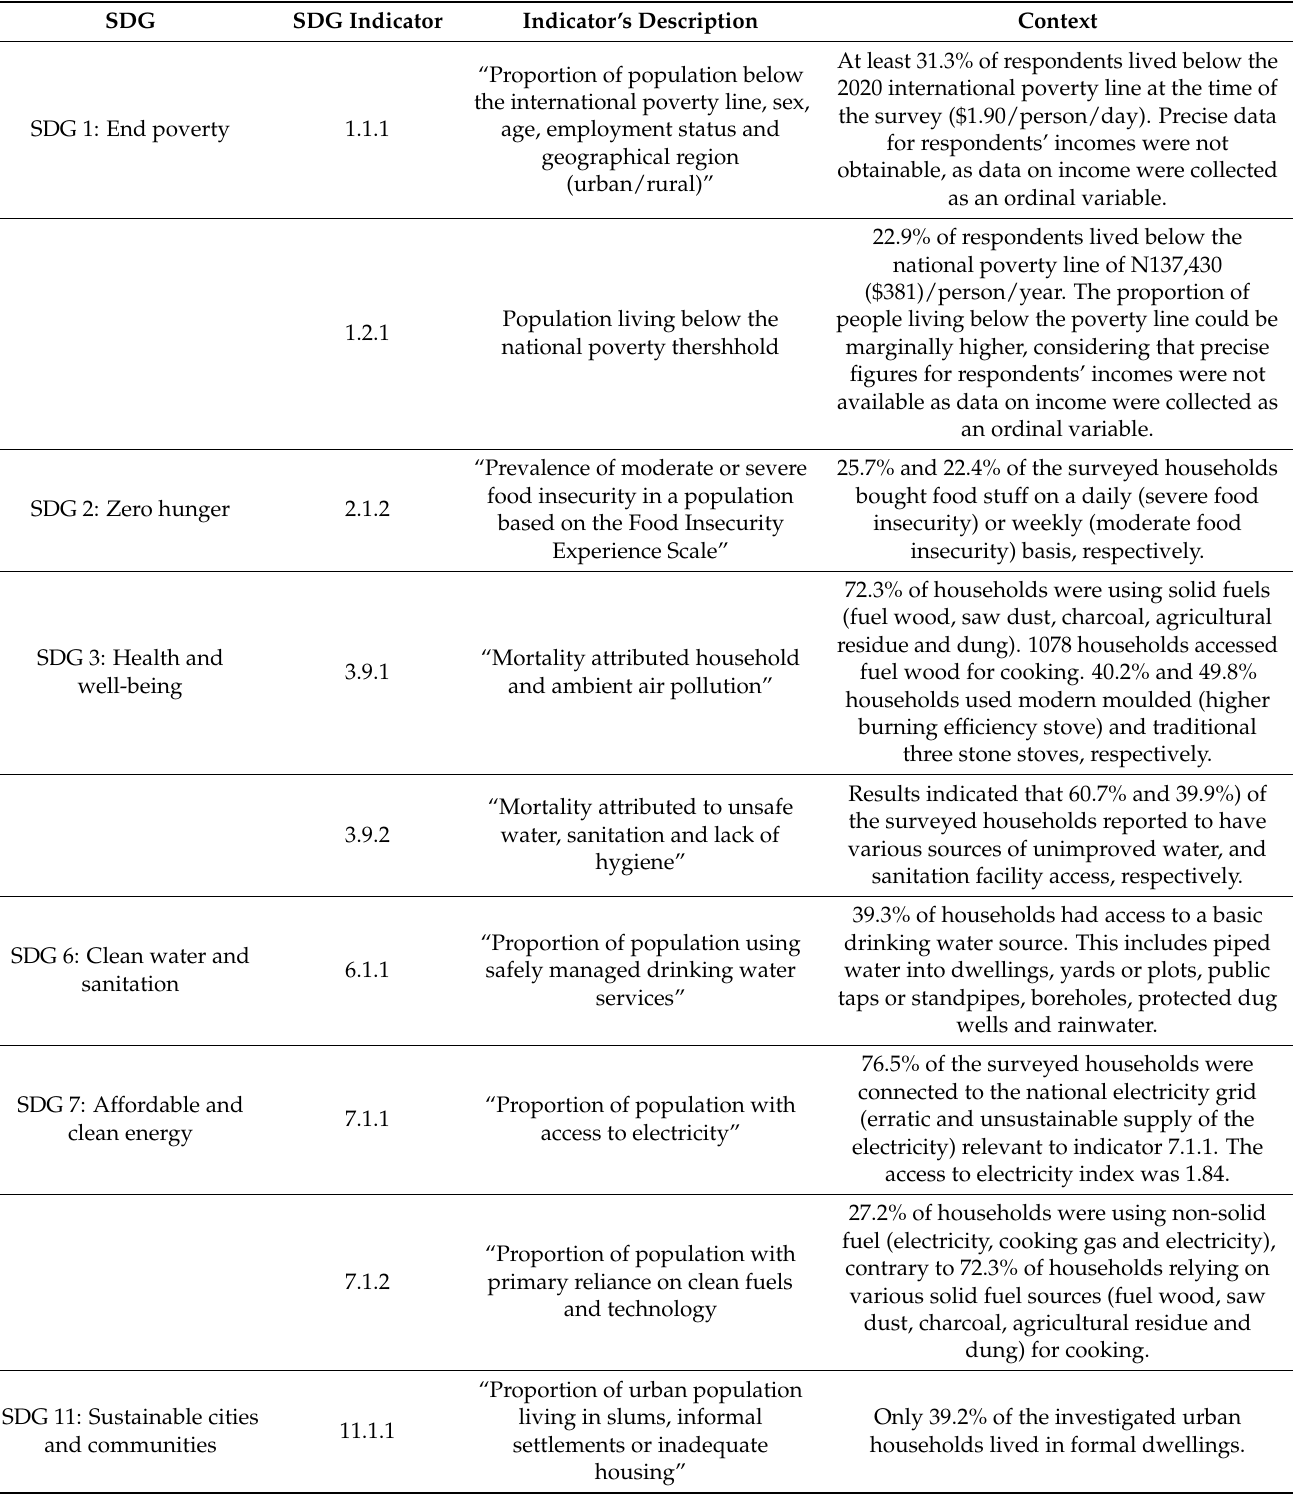
Table 11. Tracking progress towards achieving sustainable development goals (SDG) using relevant indicators in Katsina